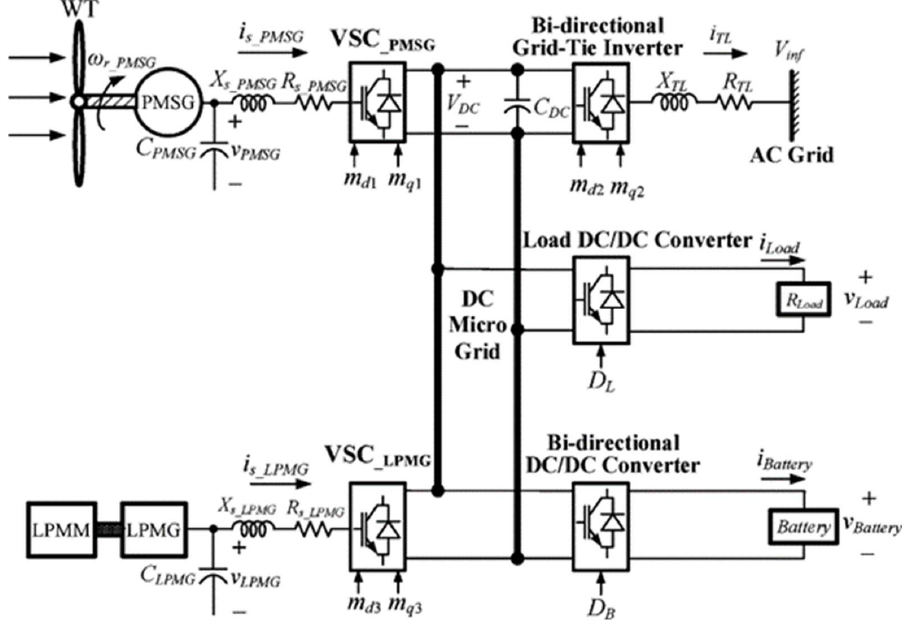
Figure 3. Schematic of a hybrid wind-wave energy system for DC power supply. Reprinted with permission from Ref. [31]. 2015, IEEE.